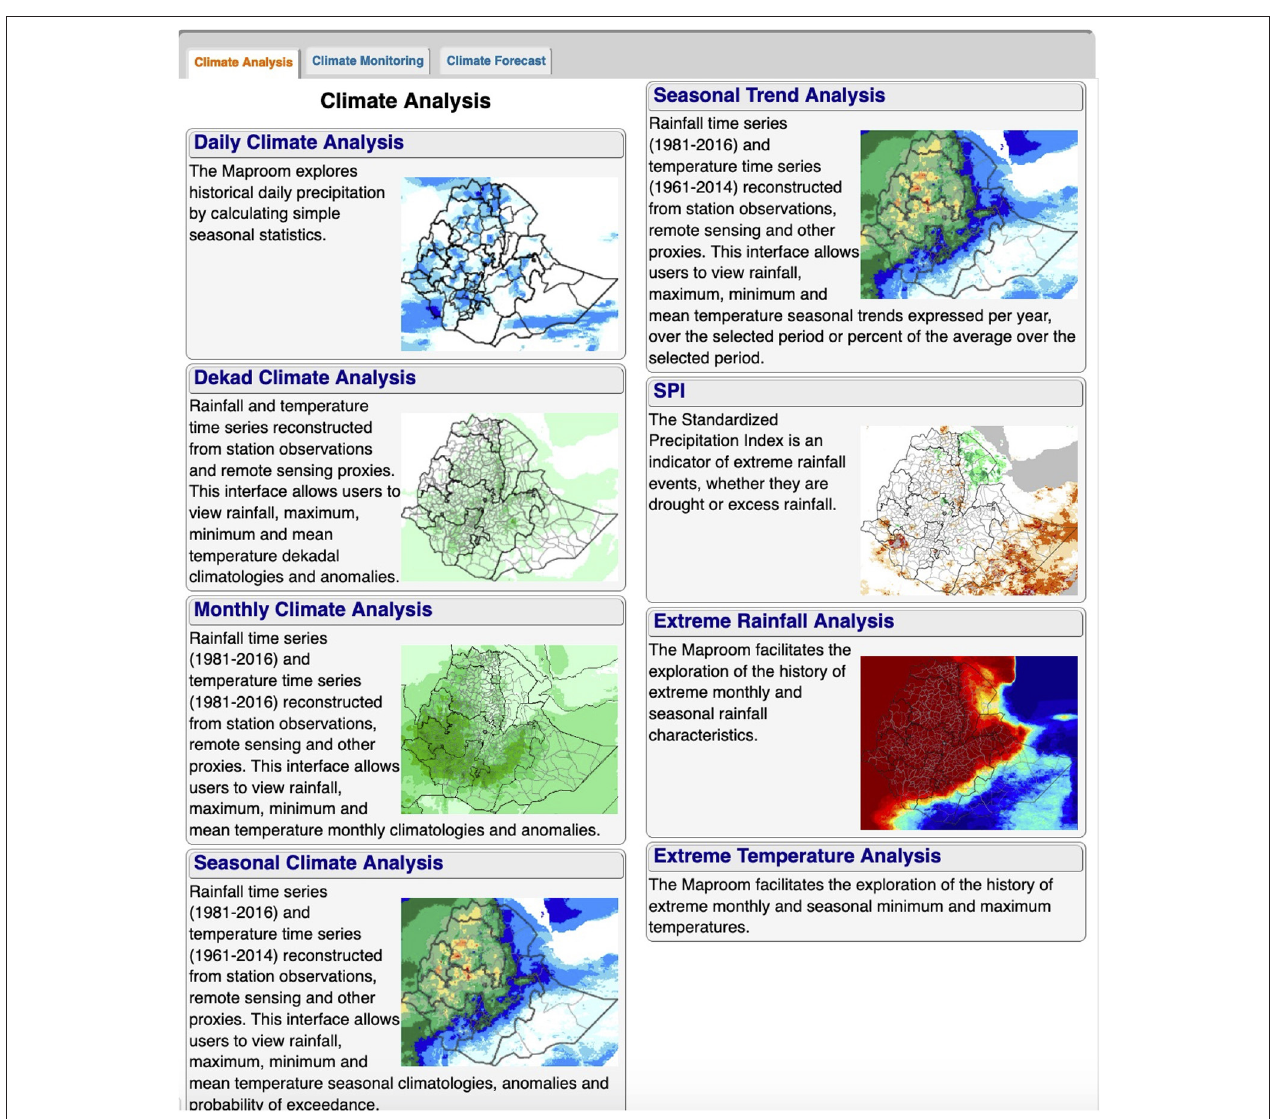
FIGURE 8 | Different products in the Climate Analysis